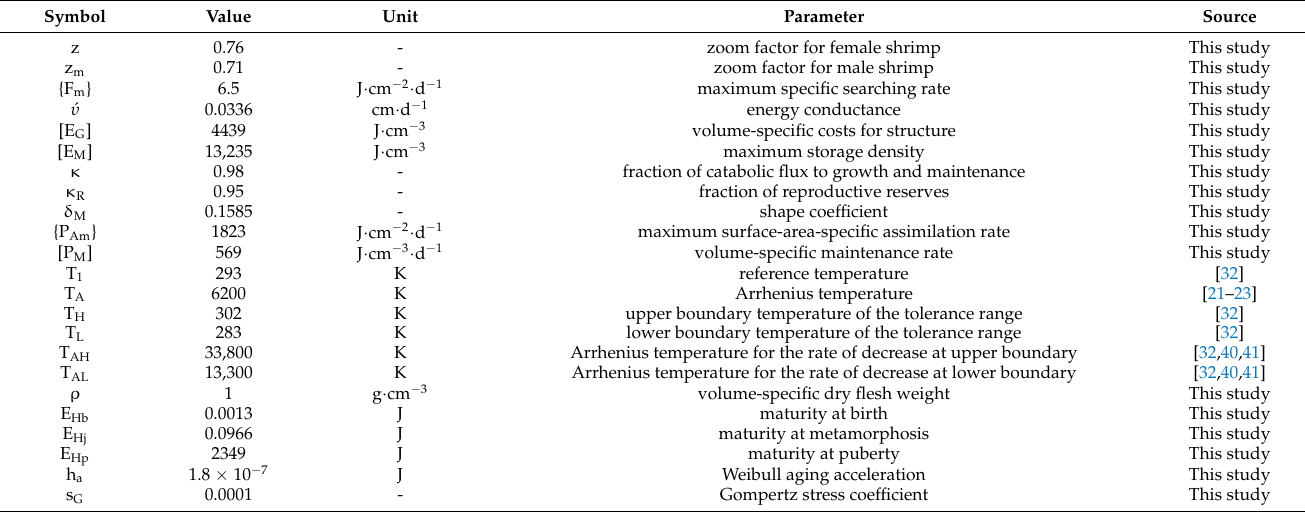
Table 3. Parameter values of the DEB model for kuruma shrimp at a reference temperature of 20 ◦